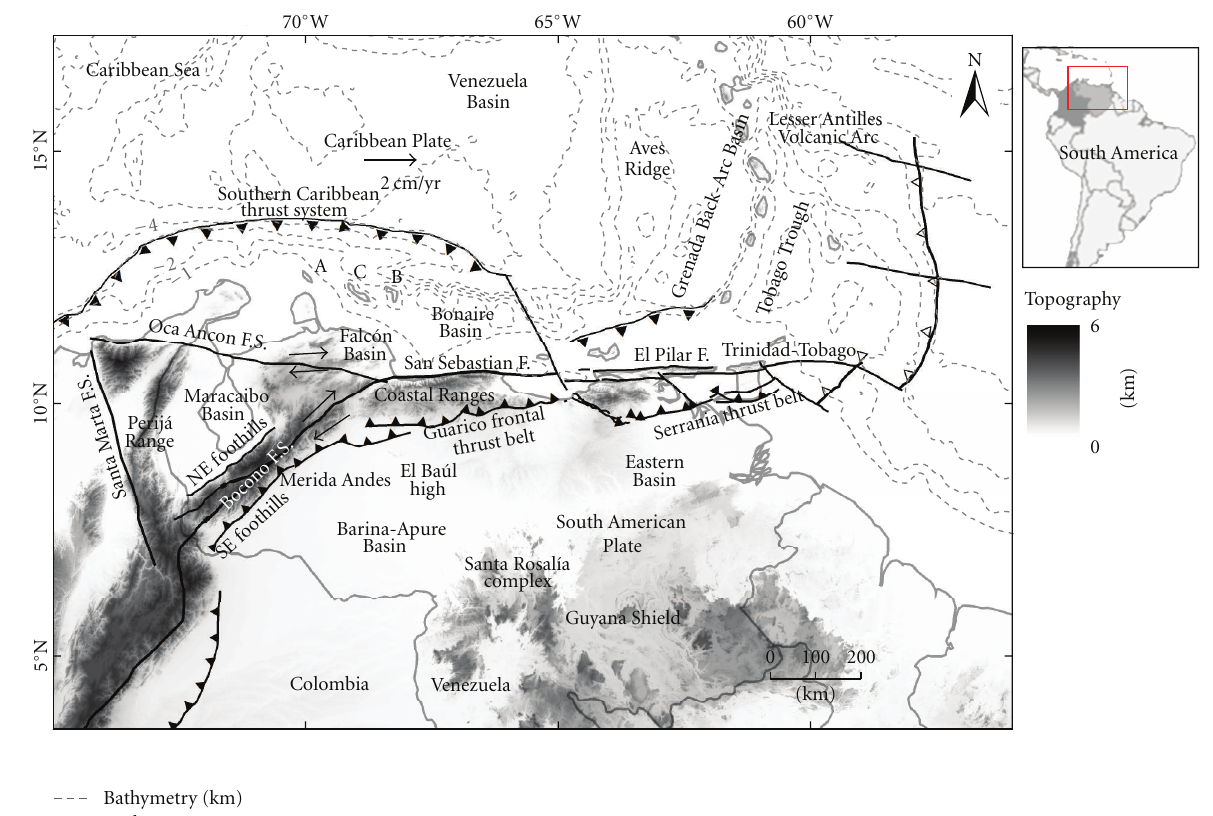
Figure 1: Study area and general tectonic and kinematic features of the northern margin of South America setting (modified from F. E. Audemard and F. A. Audemard [19]) on a digital elevation map. Arrows indicate relative regional motions. Texts indicate the name of geological or tectonic features. A, B, and C mean Aruba, Bonaire, and Curazao (ABC islands).